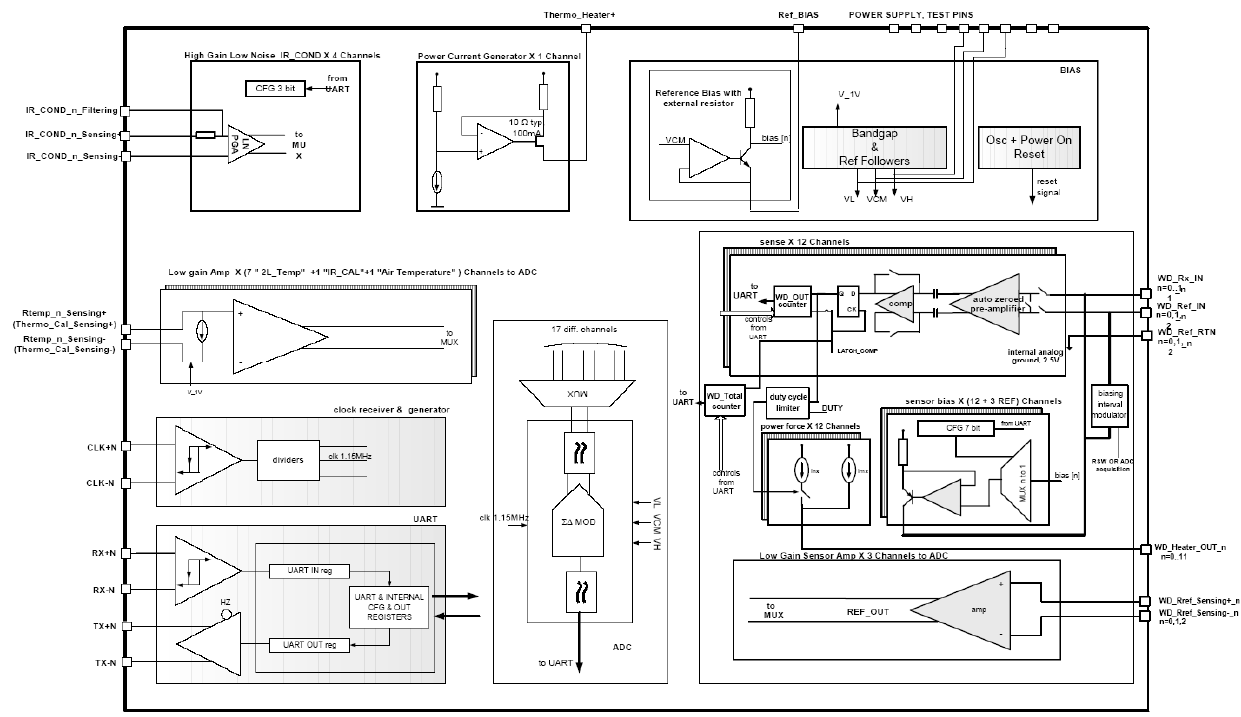
Figure 6. Simplified ASIC block diagram. Thermopile amplifier (High Gain Low Noise IR_COND), Pt1000 amplifiers (Low gain Amp), calibration plate heater driver (Power Current